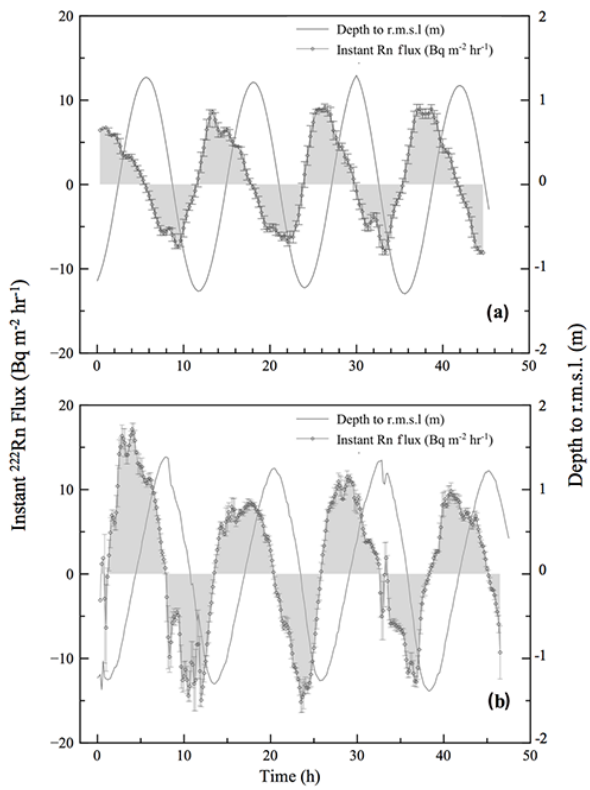
Figure 3. Tidal variability of instantaneous radon fluxes, respec- tively, at the inner Barra Nova inlet (a) and Quatro Águas sta- tion (b) , for the radon survey conducted in 2010. For more details on calculation methods, please see Sect.